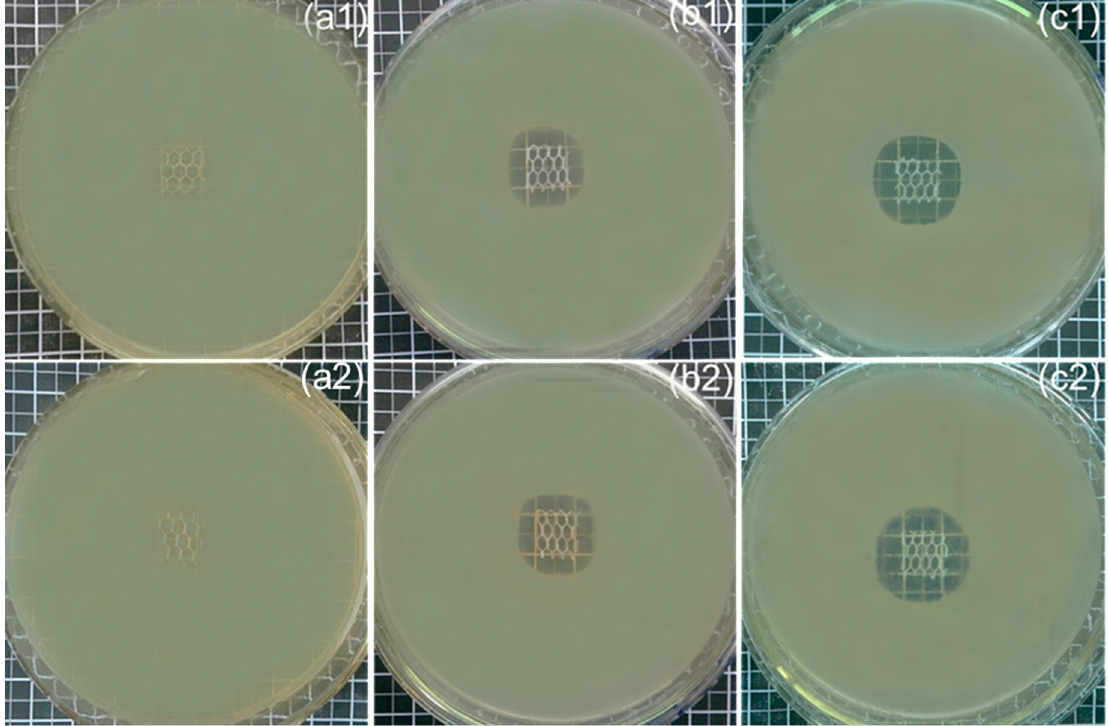
Figure 8. Inhibition zone diameter of ( a1 , a2 ) PP control, ( b1 , b2 ) CD-TCL-2, ( c1 , c2 ) CD-TCL-6, (top row) S. aureus and (bottom row) E. coli .